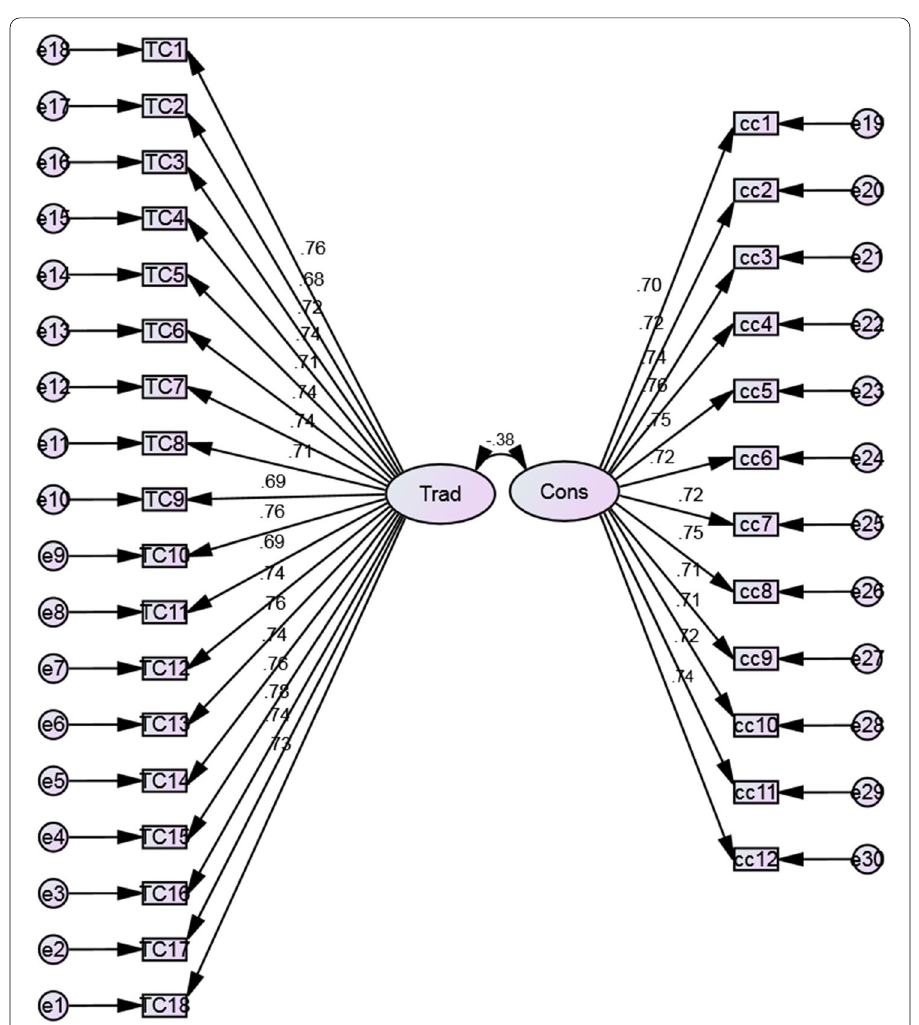
Fig. 2 Path diagram of the two-factor model for the conception about teaching and learning